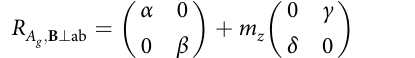
geometry). Figure 4e shows I P